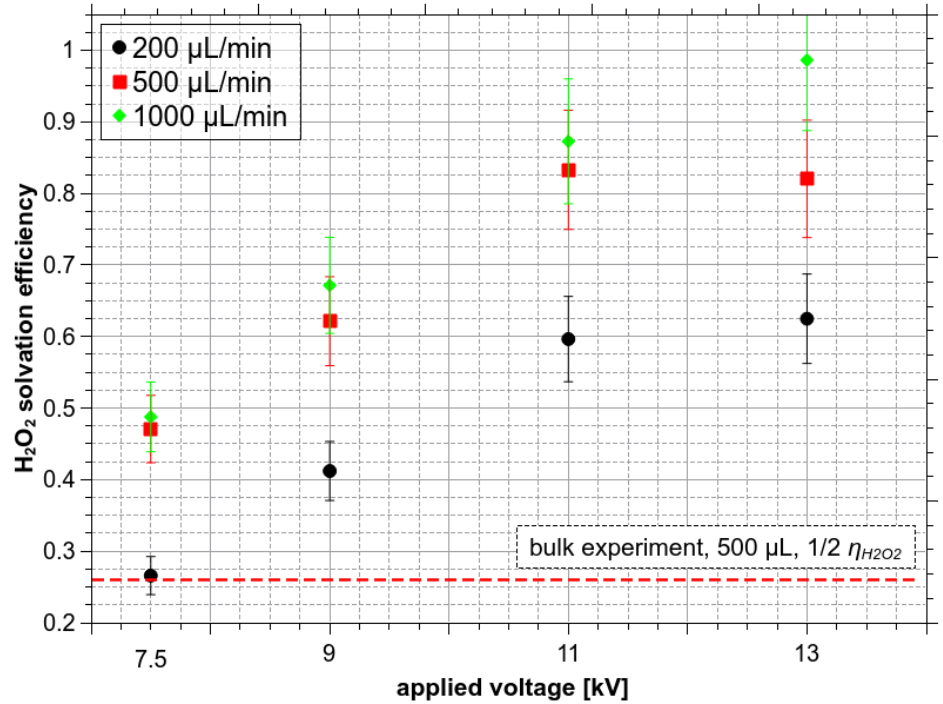
Figure 10. Solvation efficiency of H 2 O 2 at a gas flow of 1 L/min as a function of V a (kV), treatment time 1 min, at different Q w (µL/min).